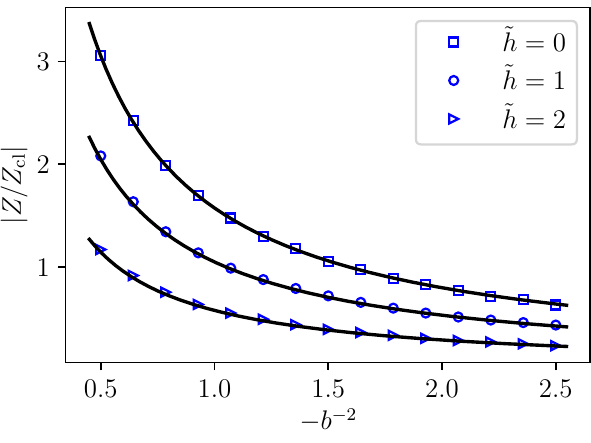
Figure 7 . Comparing the two-site path integral evaluated on Lefschetz thimbles (markers) vs. that evaluated on elementary cycles (continous curves), for various values of b 2 < 0 and ˜ h ; we chose η = 3 . The former is calculated ab initio , by constructing the thimble numericaly, see appendix B for methods. The latter is calculated by using the effective action (3.33), and numerically evaluating the integral e Z ( I ) . We divide the results by Z , which is the value of the action on the saddle point. ˜ h cl The agreement supports the claim that the Lefschetz thimbles are equivalent to the elementary cycles when b 2 < 0